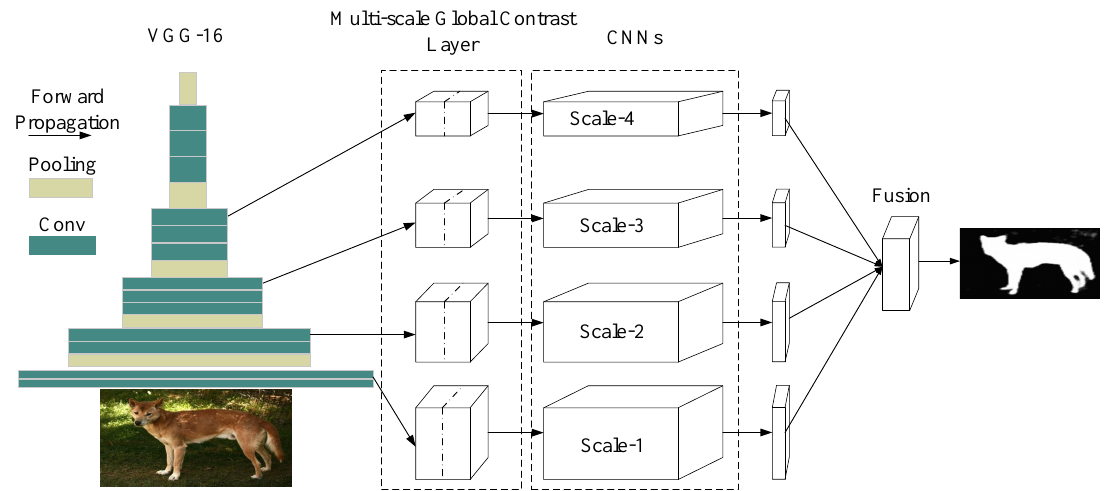
Figure 3. The architecture of the proposed multi-scale global contrast CNN